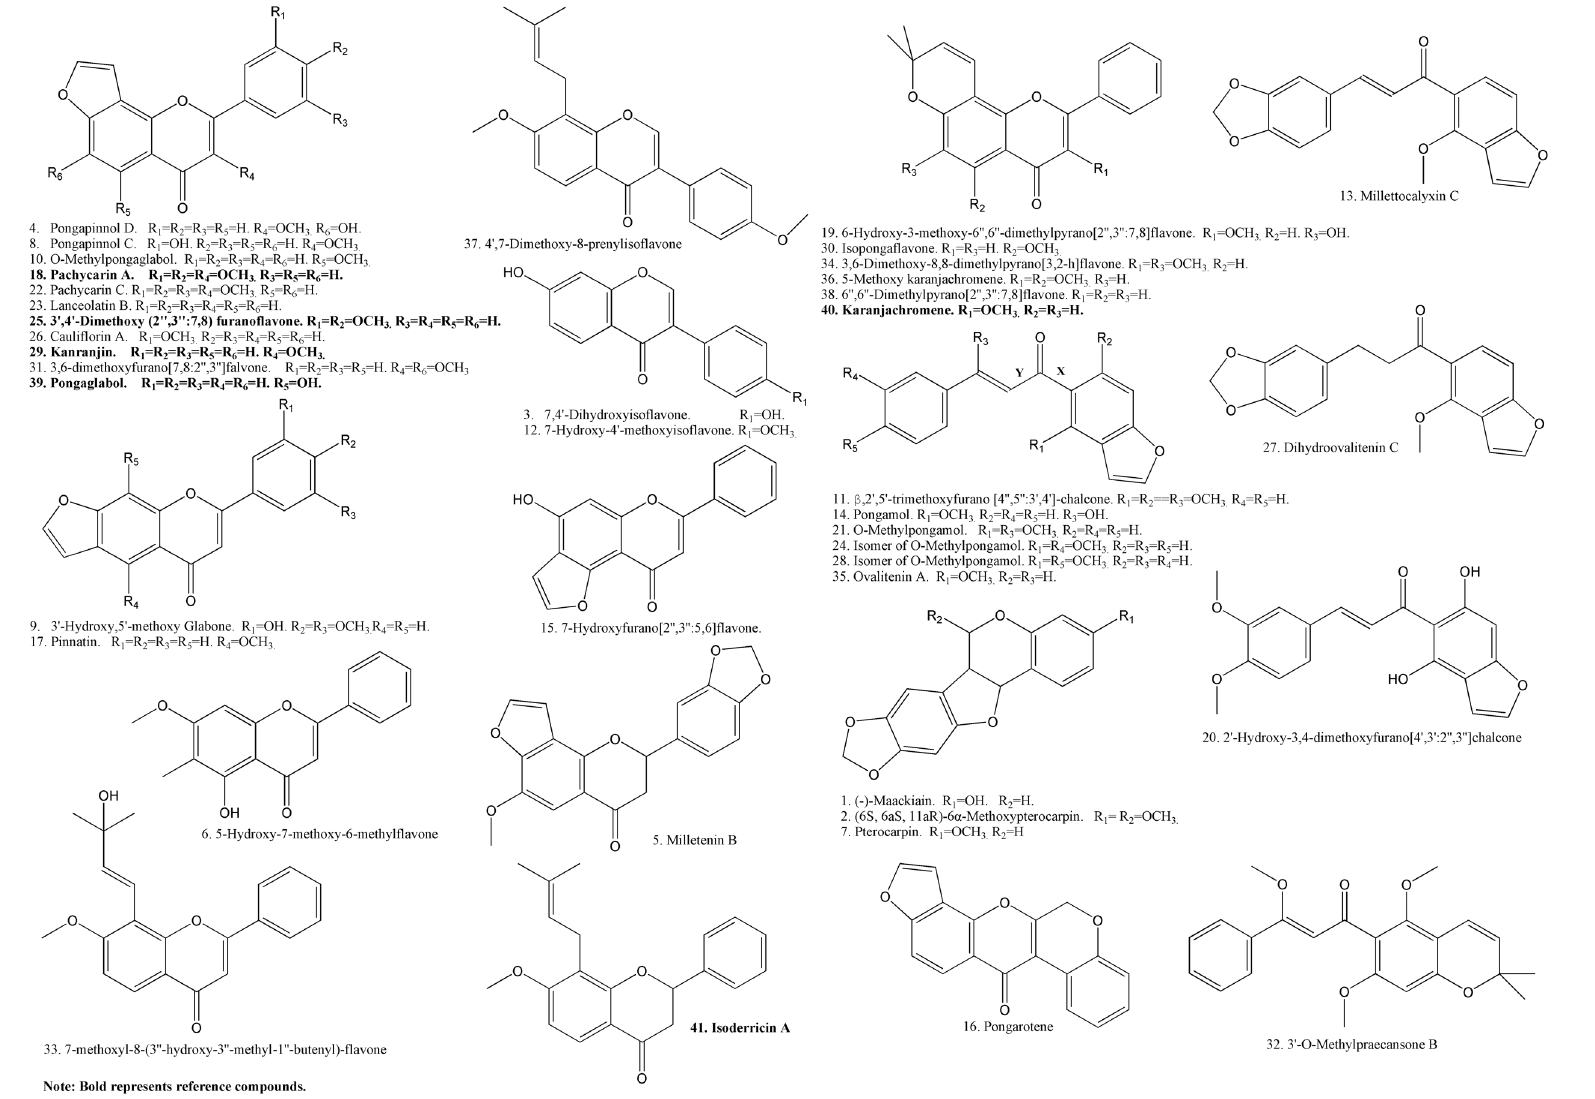
Figure 3. Structures of reference compounds and identified